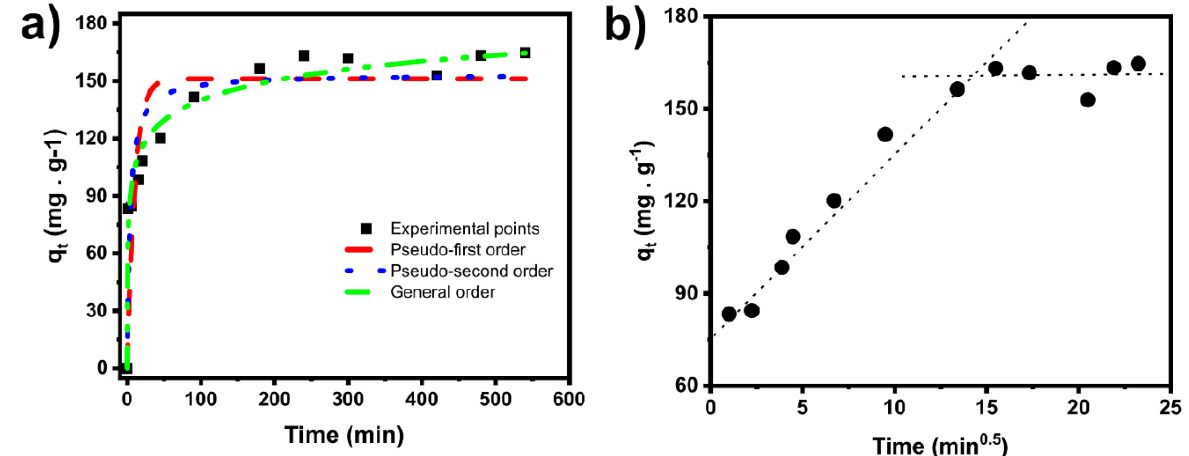
Figure 11. Kinetic fitting models and BC6 experimental curve ( a ) and intraparticle diffusion modeling ( b ). Table 4. Kinetic fitting